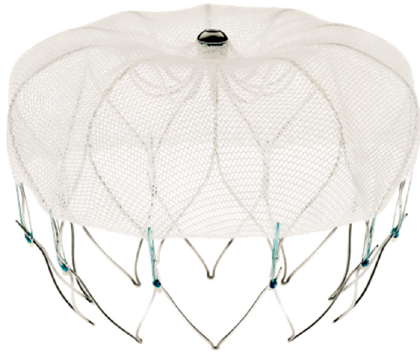
Figure 1. The Watchman device, with a 160-micron membrane on top, and the anchors are seen on bottom. (Image reproduced with permission from Boston Scientific.)